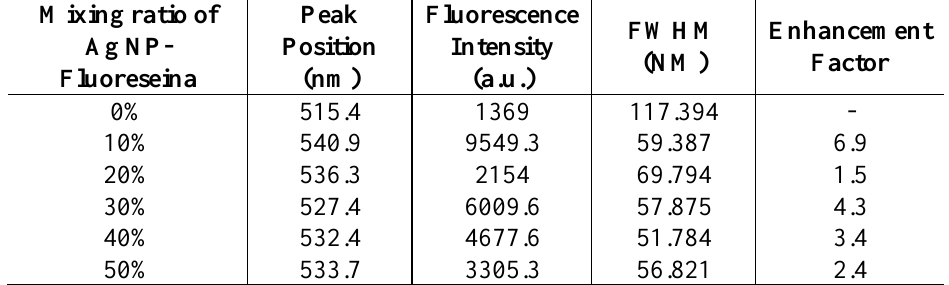
Table 1: The values of peak position, Maximum Fluorescence intensity and the Enhancement factor of Ag NPs and fluoreseina dye mixture with different mixing